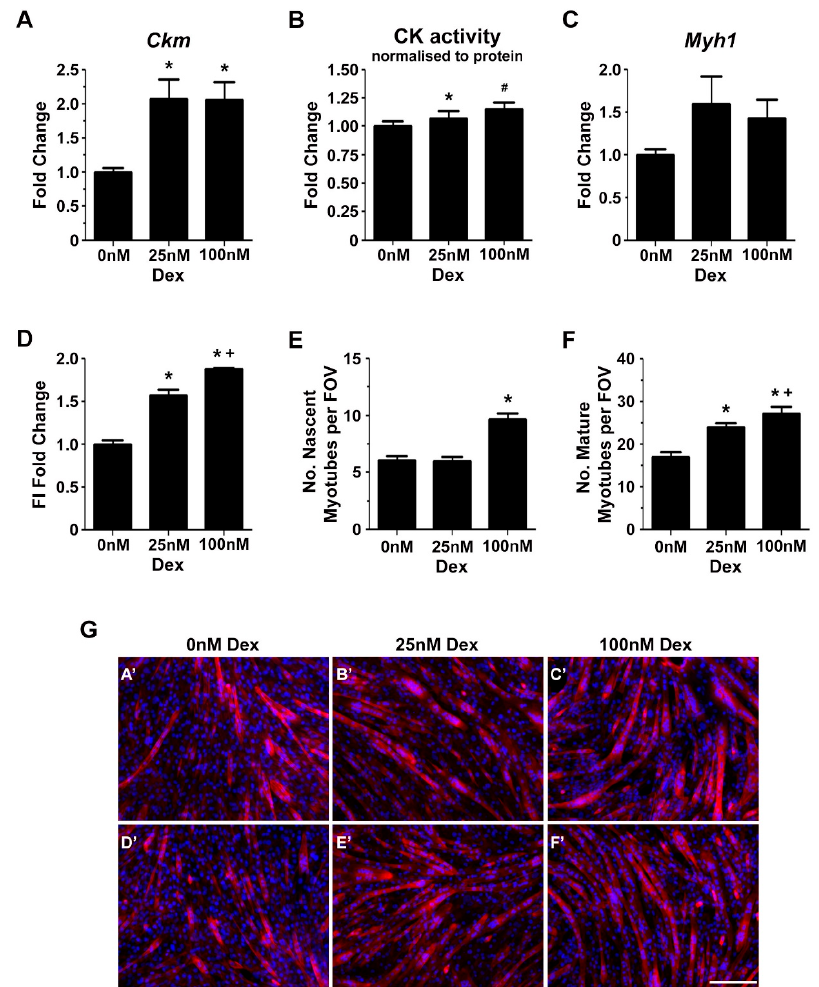
Figure 4. Low dose dexamethasone treatment for 72 h increased myogenic differentiation efficacy in C2C12 myoblasts. ( A ) The gene expression of myogenic differentiation marker creatine kinase ( Ckm ) was increased two-fold in cells treated with 25 nM and 100 nM dexamethasone (Dex) (* p < 0.01); ( B ) CK enzyme activity in cell lysates was also increased following treatment with 25 nM (* p = 0.02) and 100 nM dexamethasone ( # p = 0.01); ( C ) Dexamethasone (Dex) did not significantly increase myosin heavy chain 1 ( Myh1 ) mRNA transcripts; ( D ) Fusion index (FI; * p < 0.001) was greater in C2C12 cells treated with 25 nM and 100 nM dexamethasone compared to untreated control cells, and this increase was dose dependent ( + p < 0.05); ( E ) Treatment with 100 nM dexamethasone increased the formation of nascent myotubes containing 3–4 myonuclei (* p < 0.001); ( F ) The number of mature myotubes with ≥ 5 nuclei was greater in cultures treated with 25 nM or 100 nM versus 0 nM dexamethasone (* p = 0.017), and this increase was dose dependent ( + p = 0.03); ( G ) Representative images of C2C12 myotubes. Differentiation C2C12 myoblasts were treated with 0 nM dex ( A’ , D’ ), 25nM dex ( B’ , E’ ) or 100 nM dex ( C’ , F’ ) for 72 h. Myotubes were then stained with phalloidin for F-actin (red) and DAPI for nuclei (blue). CK enzyme activity was calculated from n = 3 biological replicates performed in quadruplicate. The fusion index and myotube number were calculated from n = 3 biological replicates performed in duplicate. Gene expression was determined from n = 3 biological replicates in triplicate. Scale bar = 200 µ m. Error bars =